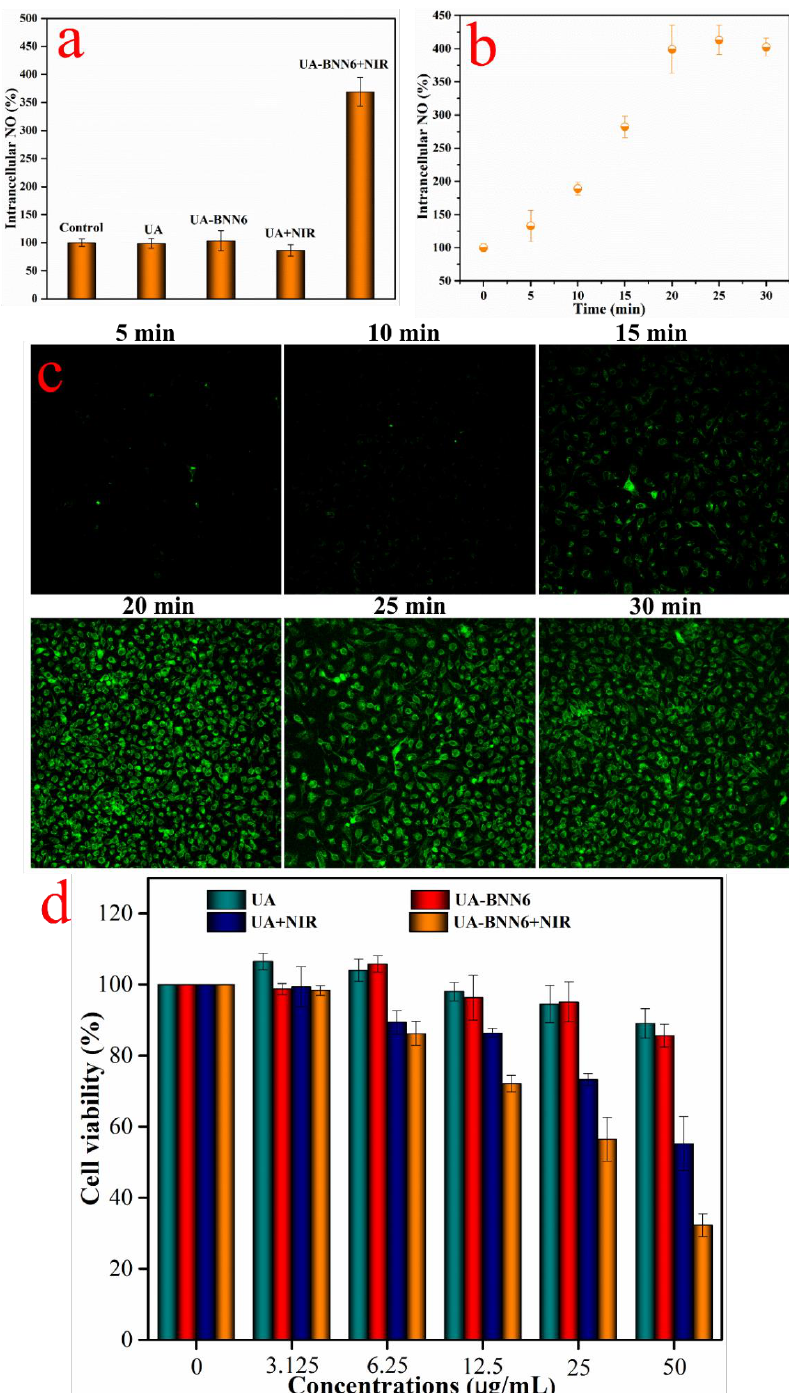
Figure 6. ( a ) Intracellular NO generation in HeLa cells after being treated with UA, UA-BNN6, UA+NIR, and UA-BNN6+NIR. The untreated cells were used as the control. ( b ) Intracellular NO generation in HeLa cells after being treated with UA-BNN6+NIR at different time intervals. ( c ) Fluorescence confocal images of the intracellular generation of NO in HeLa cells after treatment with UA-BNN6+NIR at different time intervals. DAF-FM DA was used as the NO fluorescent probe. ( d ) The viabilities of HeLa cells after being treated with UA, UA-BNN6, UA+NIR, and UA-BNN6+NIR (808 nm, 1.0 W cm − 2